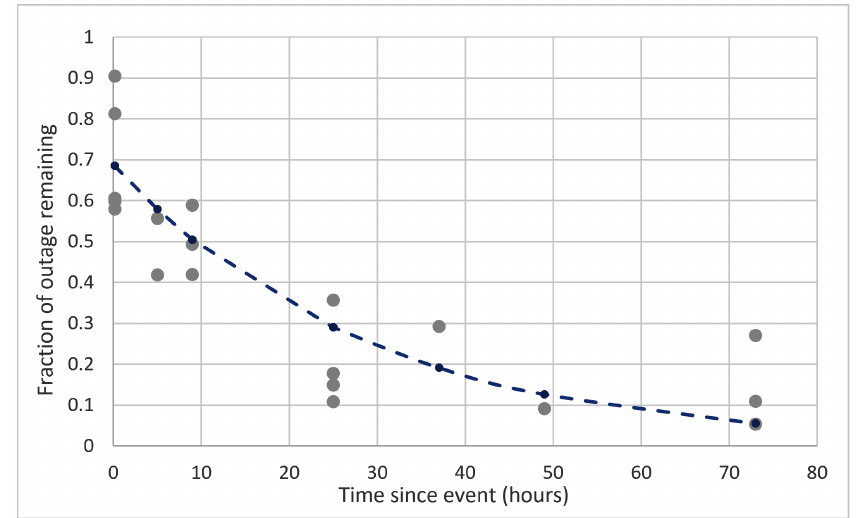
Figure 8. The exponential decay curve for the fraction of the outage remaining as a function of